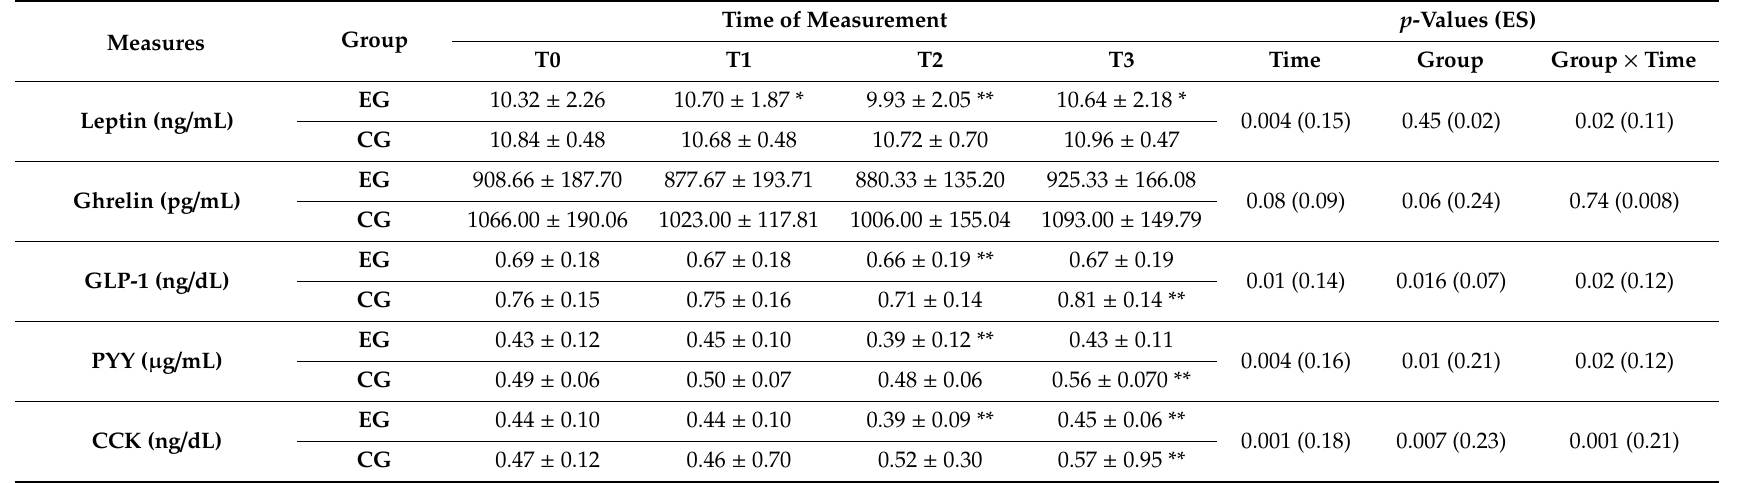
Table 3. Gut hormone concentrations (means ± SD) of the experimental group (EG) and control group (CG) measured 24 h before the start of Ramadan (T0), on the 15th day of Ramadan (T1), the day after the end of Ramadan (T2) and 21 days after the end of Ramadan